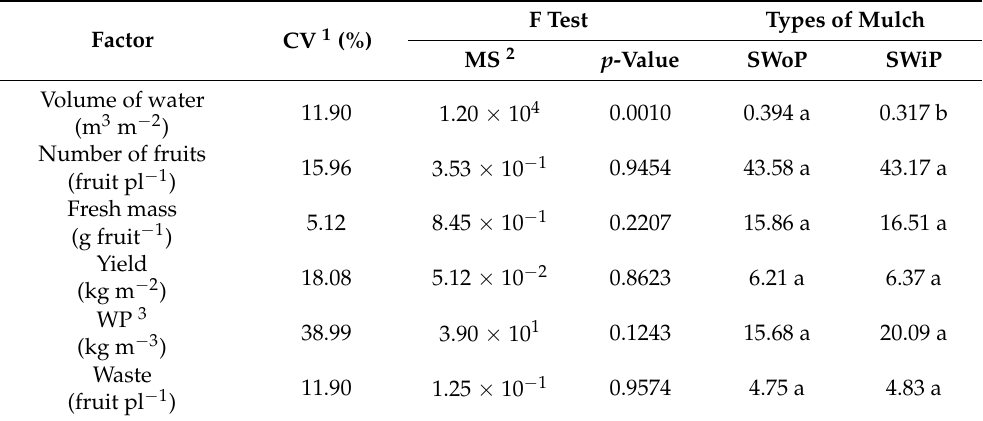
Figure 6. Relationship between the normalized difference vegetation index (NDVI) and Kc ob- tained for strawberry cultivated with recycled paper mulch (SWiP), using the ( A ) lysimeter (L) and ( B ) Penman–Monteith (PM) methods. Table 2. Summary of the analysis of variance and mean data of agronomic characteristics of strawberry cultivated in lysimeters with recycled paper mulch (SWiP) and without recycled pa- per mulch